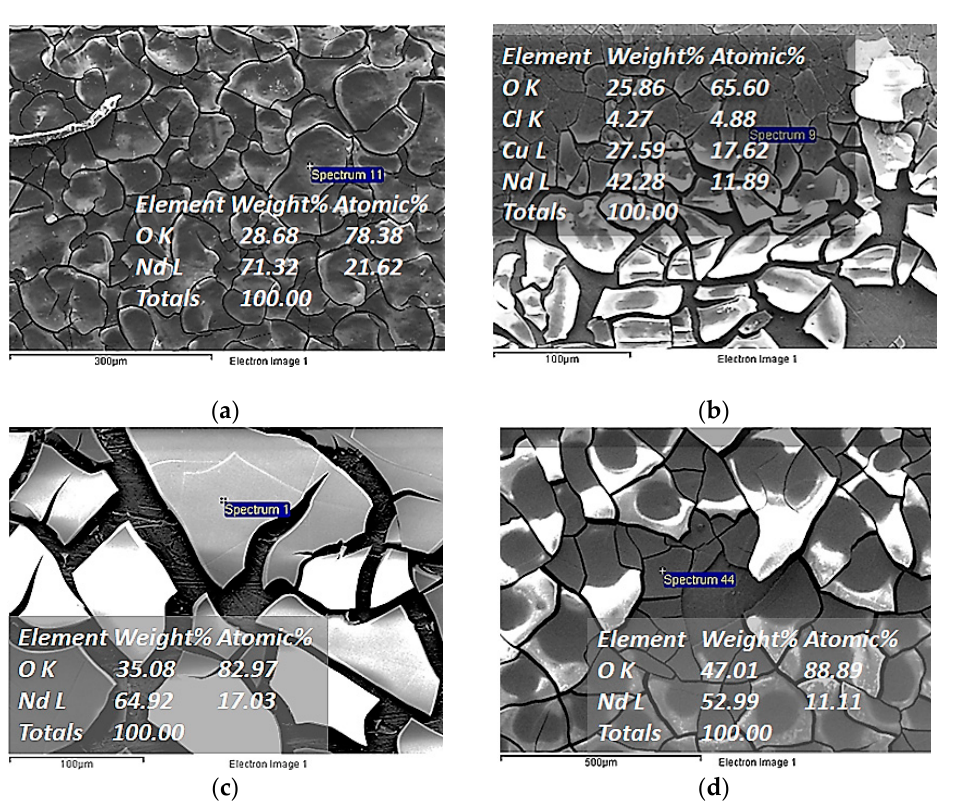
Figure 5. Scanning Electron Microscopy-Energy Dispersive X-Ray Spectroscopy (SEM-EDS) analysis of the electrodeposits produced by ( a ) Galvanostatic polarization, ( b ) Potentiostatic polarization, ( c ) Current pulsed electrolysis, and ( d ) Potential Pulsed electrolysis.